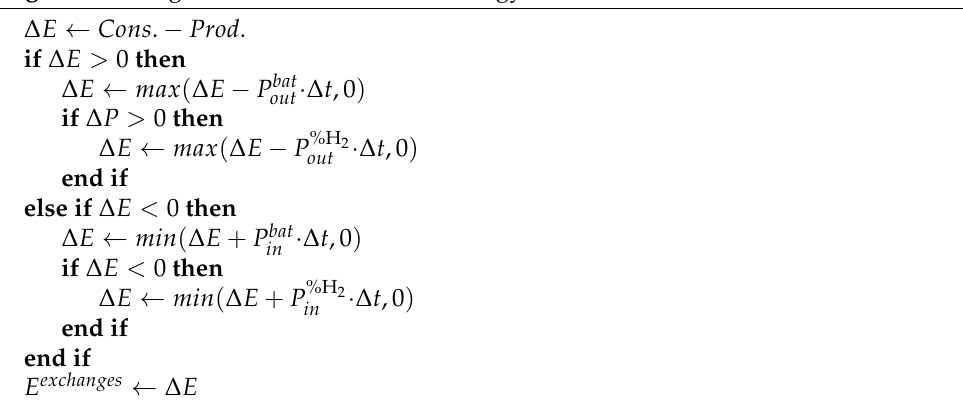
Algorithm 1 Algorithm of the first case